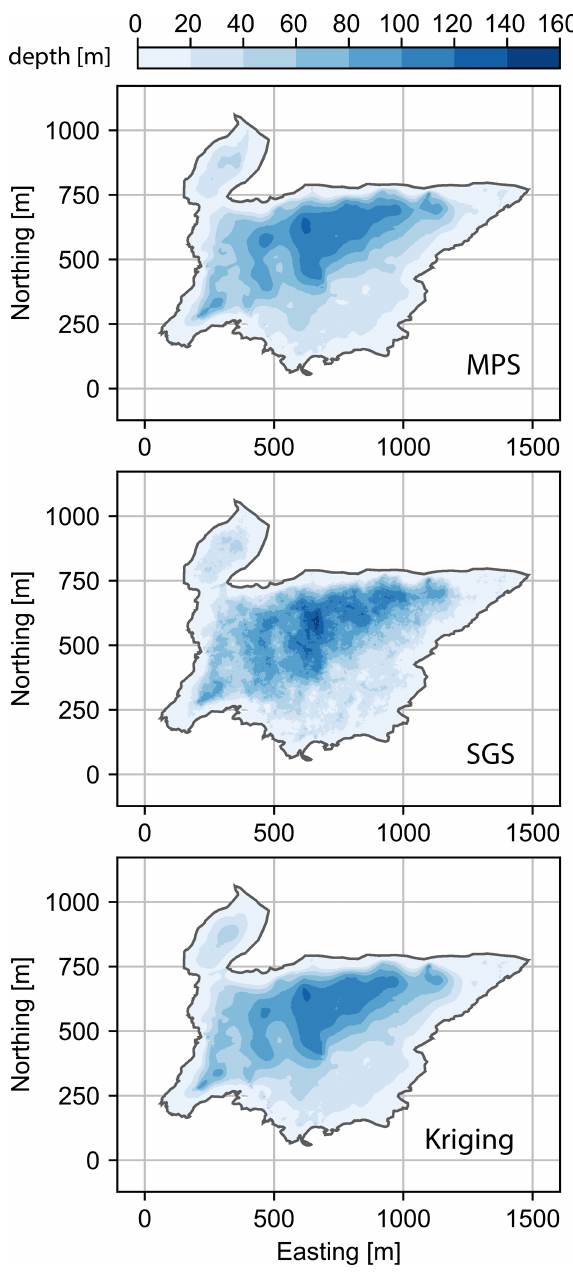
Figure 10. Ice thickness calculated from the three methods using the 2019 surface DEM. The SGS and the MPS basal models used are the averaged model over all the